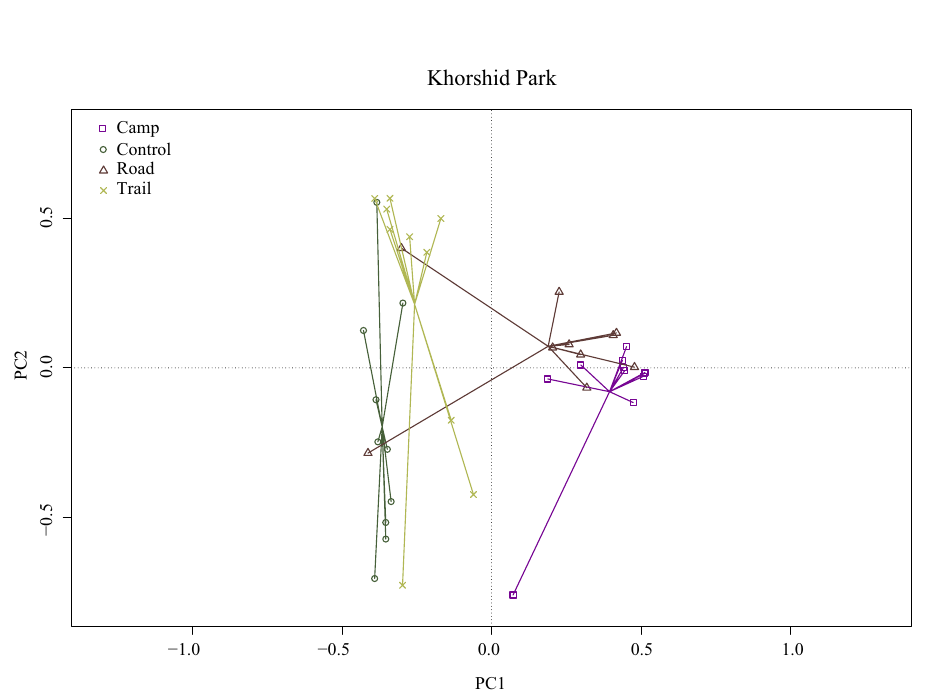
Figure 3. Transformation-based principal component analysis (tb-PCA) plot of variation in species composition along transects sampled in Khorshid Park. Communities (hiking trail, dirt road, campsite, control) are indicated with different colours, each symbol represents a